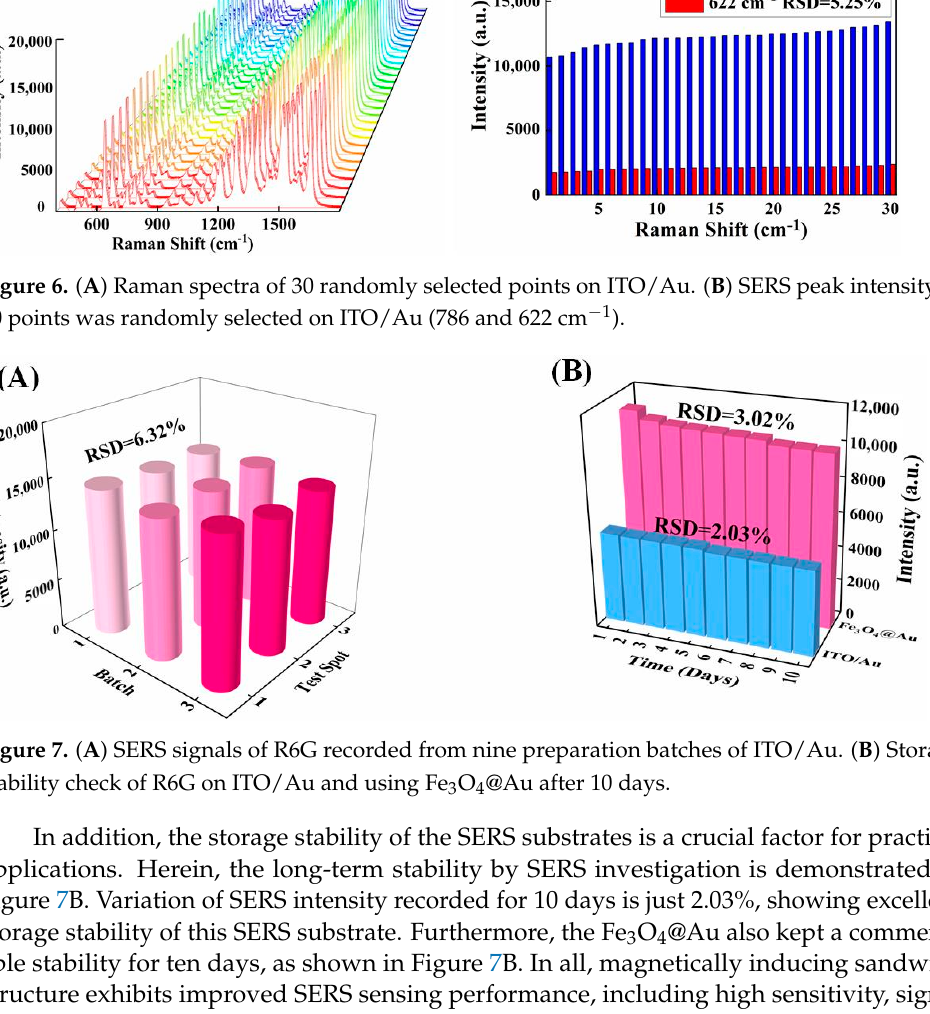
Figure 6. ( A ) Raman spectra of 30 randomly selected points on ITO/Au. ( B ) SERS peak intensity of 30 points was randomly selected on ITO/Au (786 and 622 cm − 1 ).